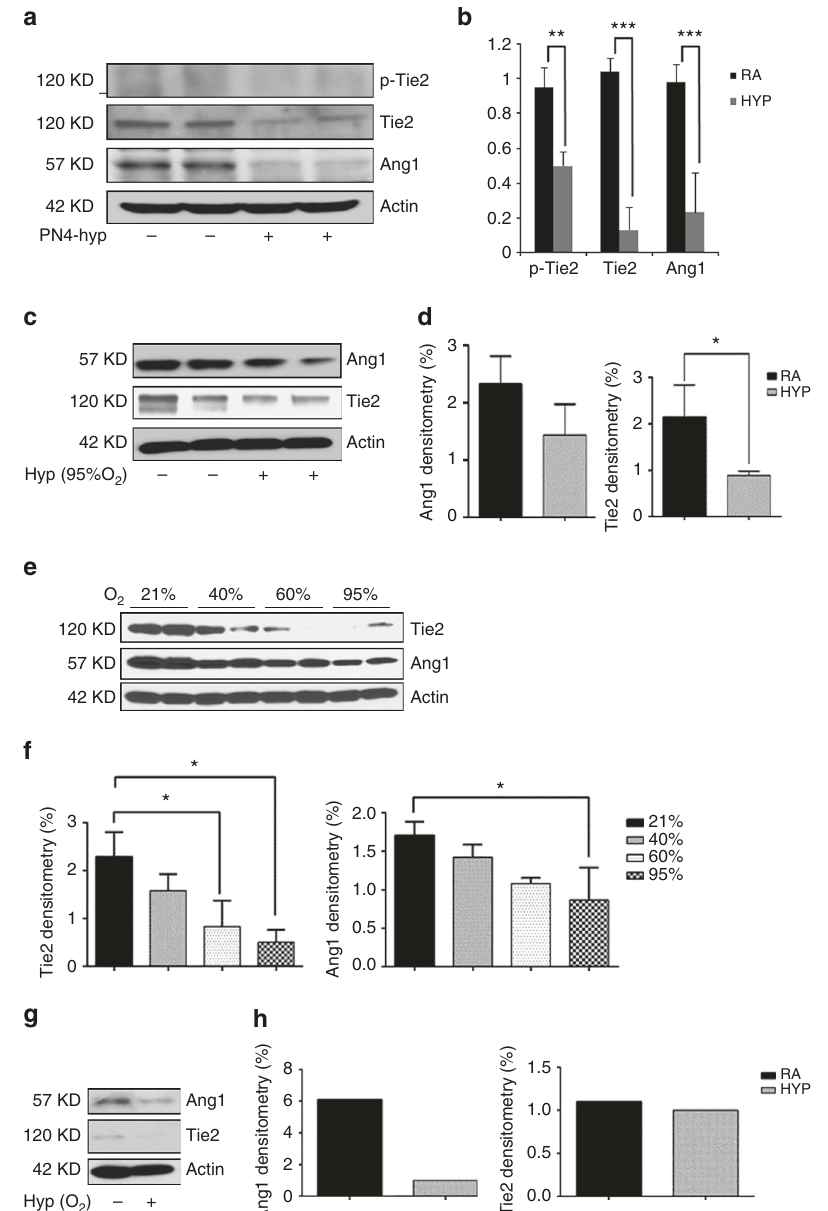
Fig. 2 Hyperoxia downregulates Ang1-Tie2 signaling in developing lungs. NB WT mice were exposed to hyperoxia from PN day 1 − 4. a Western blots showing decreased expression of Phospho-Tie2, Tie2 and Ang1. b Densitometric analysis was completed and the expression of detected proteins was normalized to β -actin. c , d MLE12 cells were incubated with or without the presence of hyperoxia (95% O 2 ) for 24 h. Western blot analysis showed downregulation of Tie2 and Ang1, quanti fi ed in D. e , f Western blot showing decreased Tie2 and Ang1 expression in MLE12 cells, which were exposed to different concentrations of oxygen (21, 40, 60, and 95%) for 48 h, quanti fi ed in F. g , h Freshly isolated type 2 epithelial cells were incubated in absence and presence of HYP (95% O 2 ) for 4 h and western blot performed for Ang1 and Tie2 expression, quanti fi ed in H ( n = 1). WT: Wild-type; NB: newborn; PN: postnatal; Ang1: Angiopoietin 1; RA: room air; HYP: hyperoxia. Values are means + SEM of a minimum of four observations (in vitro experiments,